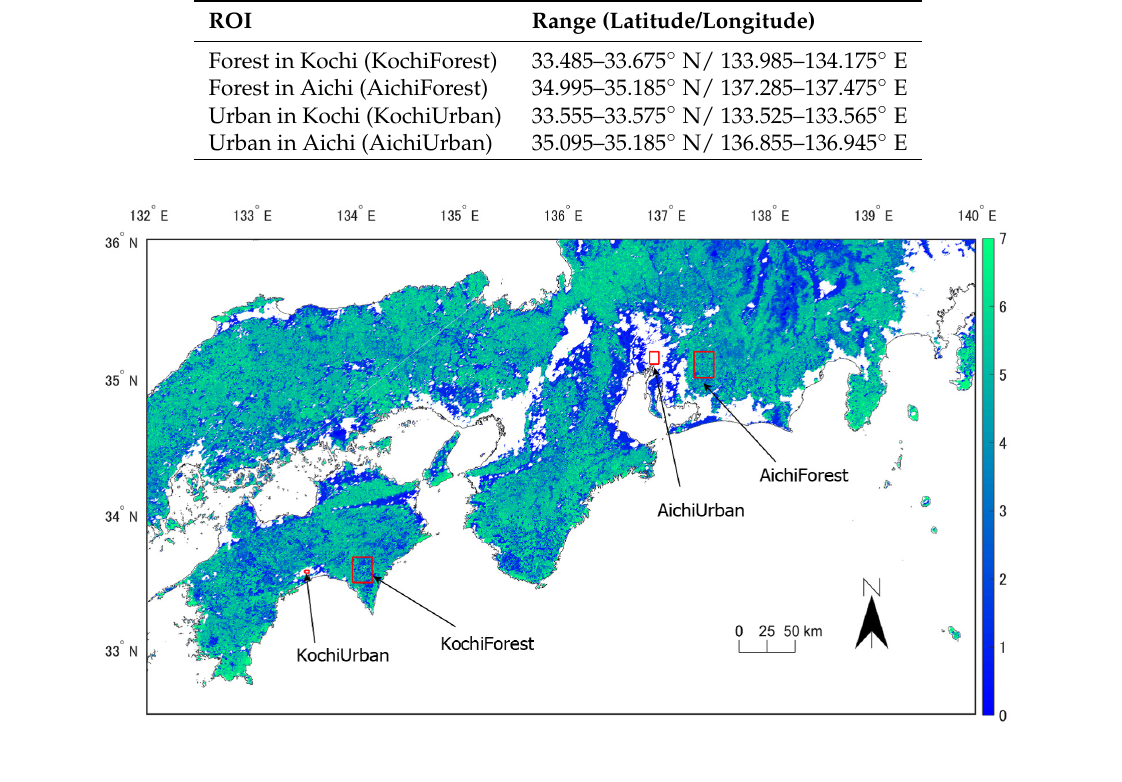
Figure 3. Spatial distribution of the LAI in the western part of Japan, based on the MOD15A2H data collected on 17 May 2017. Four ROIs are indicted by rectangles. LAI values of the non-vegetated regions, such as the urban and ocean regions, are represented by the white